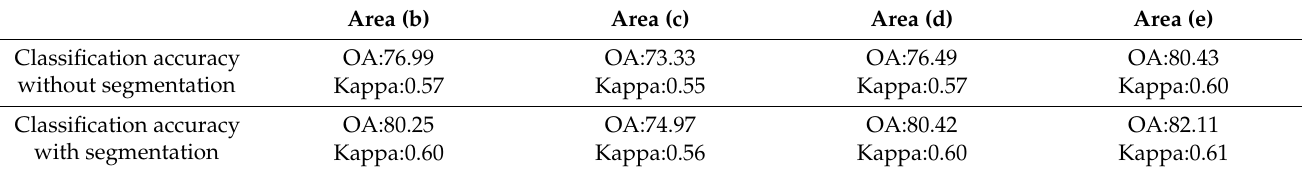
Figure 7. ( a ) The whole area is divided into four small areas, ( b ) the classification result of area ( b ) after segmentation processing, ( c ) the classification result of area ( c ) after segmentation processing, ( d ) the classification result of area ( d ) after segmentation processing, and ( e ) the classification result of area ( e ) after segmentation processing. Table 3. Classification results of using improved point cloud interpolation method by the random forest classifier.